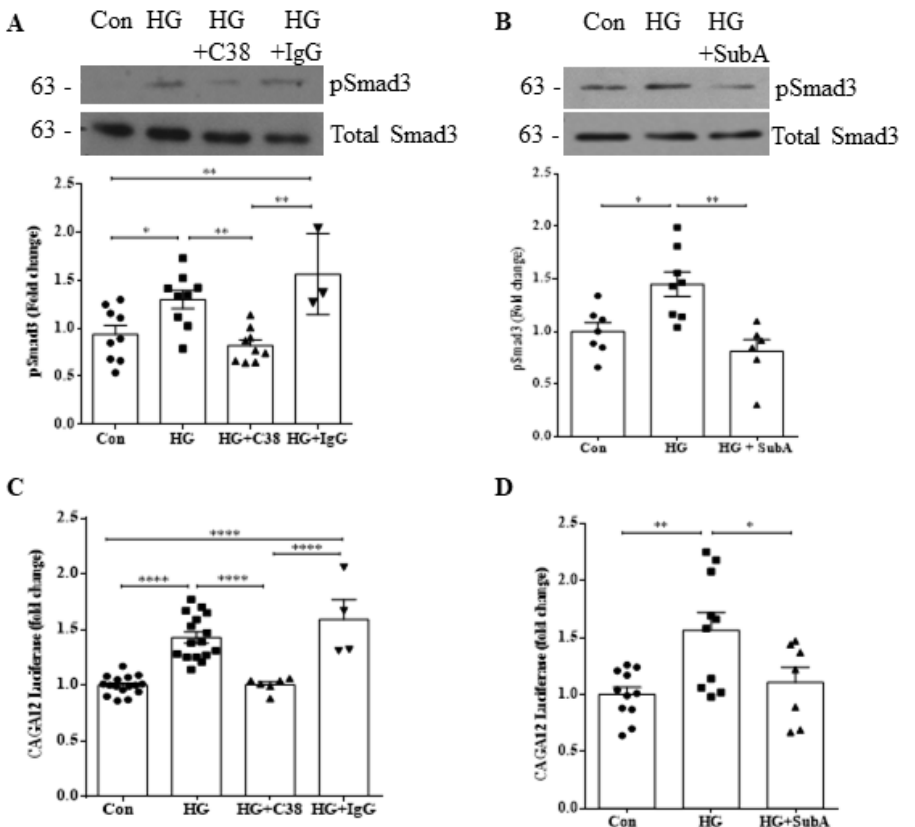
Figure 3. csGRP78 facilitates HG-induced Smad3 activation. HG (48 h)-induced Smad3 activation, assessed by its C-terminal phosphorylation at Ser473/475, was prevented by csGRP78 inhibition with ( A ) C38 antibody, but not nonspecific IgG (2 µg, n = 9, * p < 0.05, ** p < 0.01) or ( B ) SubA (25 ng/mL, n = 8, * p < 0.05, ** p < 0.01). HG (48 h)-increased Smad3 transcriptional activity, assessed using the Smad3-responsive CAGA12 luciferase reporter, was also prevented by csGRP78 inhibition with ( C ) C38 ( n = 16) or ( D ) SubA ( n = 12, * p < 0.05, ** p < 0.01, **** p < 0.0001).